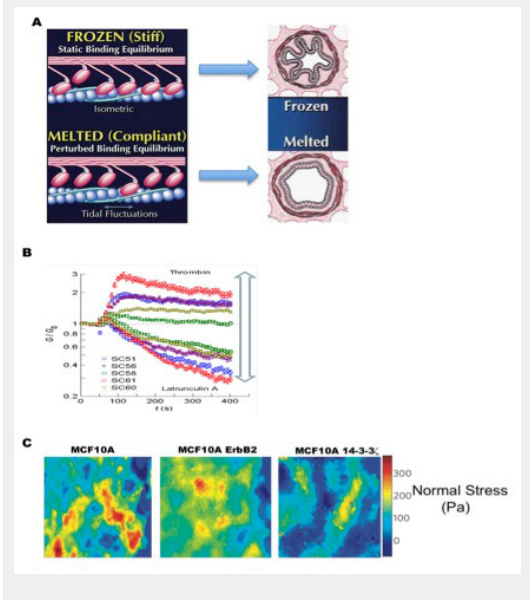
Bridging the gap between cell mechanics and health. (A) In asthma the ability of the ASM properly to fluidize and resolidfy is disturbed: actin-myosin contractility is abnormal since more myosin remains attached to actin filaments at any given time, resulting in the airway being in a “frozen” state. However, in normal ASM less myosin is attached to actin filaments, allowing the airways to more readily deform at will, representing a “melted” state. (B) Schlemm’s canal cells treated with drugs known to decrease or increase aqueous humour outflow resistance surprisingly had equivalent effects on cell stiffness, providing possible therapeutic opportunities for sufferers of glaucoma. (C) The normal stress distribution of the MCF10A breast cancer cell line over-expressing the oncogenes ErbB2 (HER-2/Neu) or 14-3-3ζ, or vector (control) were observed to be remarkably distinct among one another. Cell lines expressing each oncogene reflected contrasting epithelial (ErbB2 (HER-2/ Neu)) and mesenchymal (14-3-3ζ) cell behaviours. Adapted